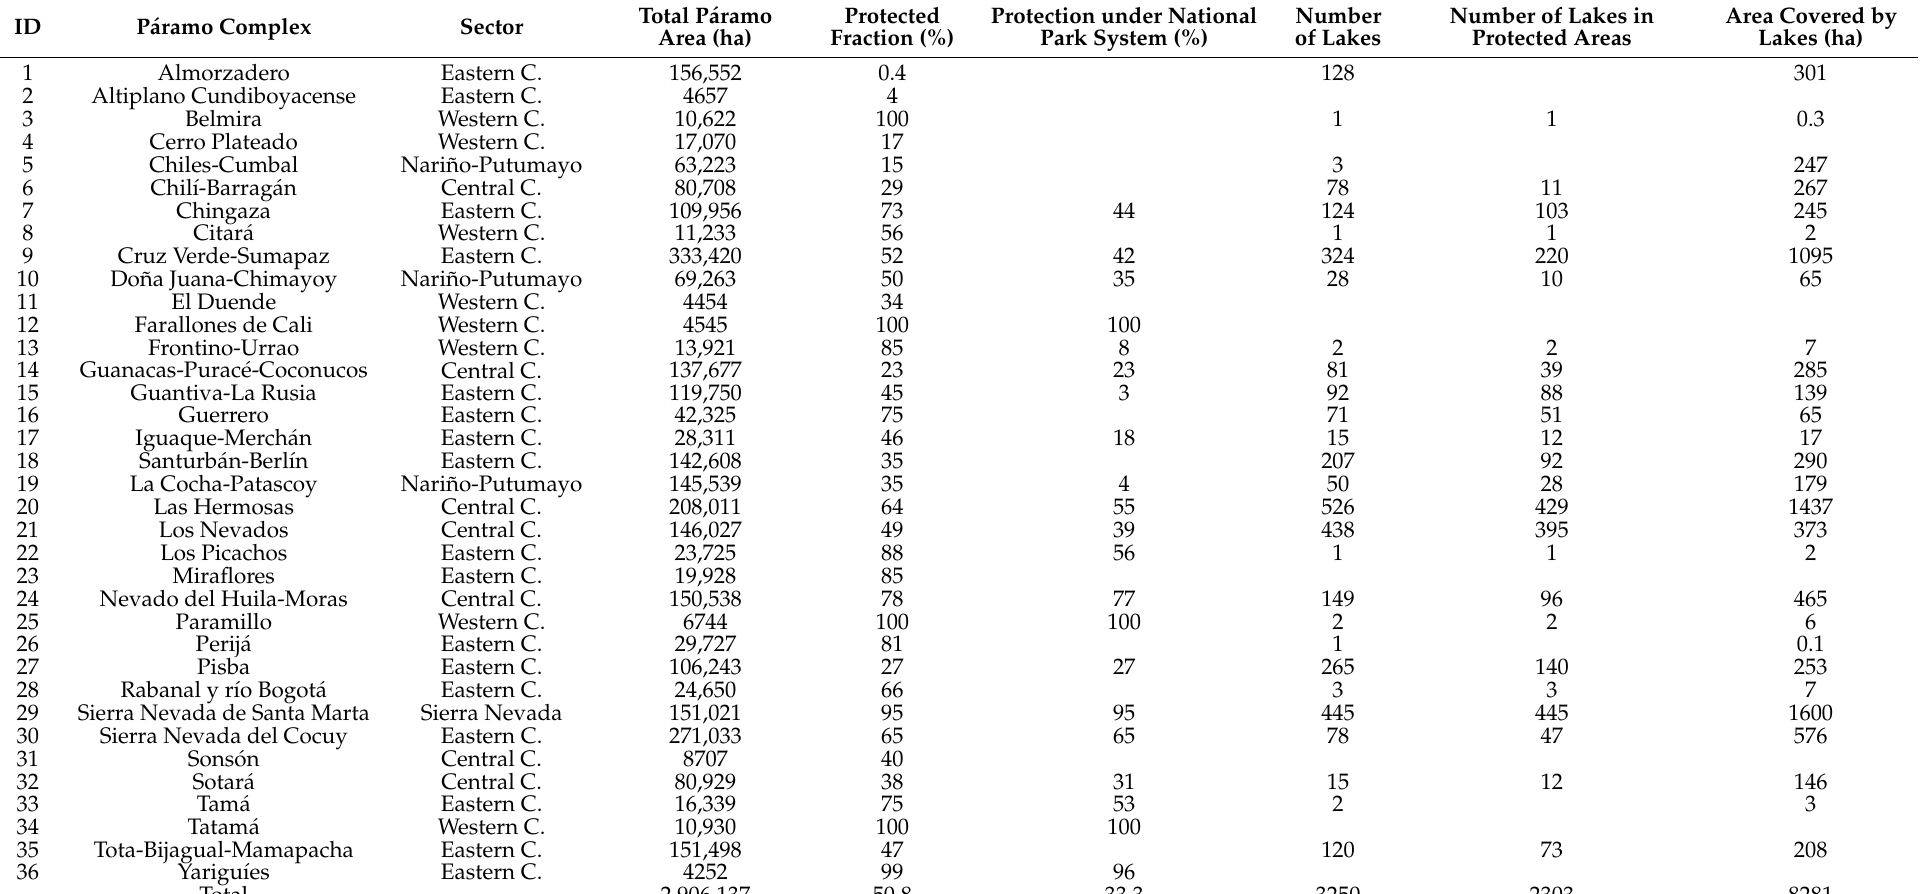
Table 1. P á ramo complexes of Colombia and lake distribution. C: